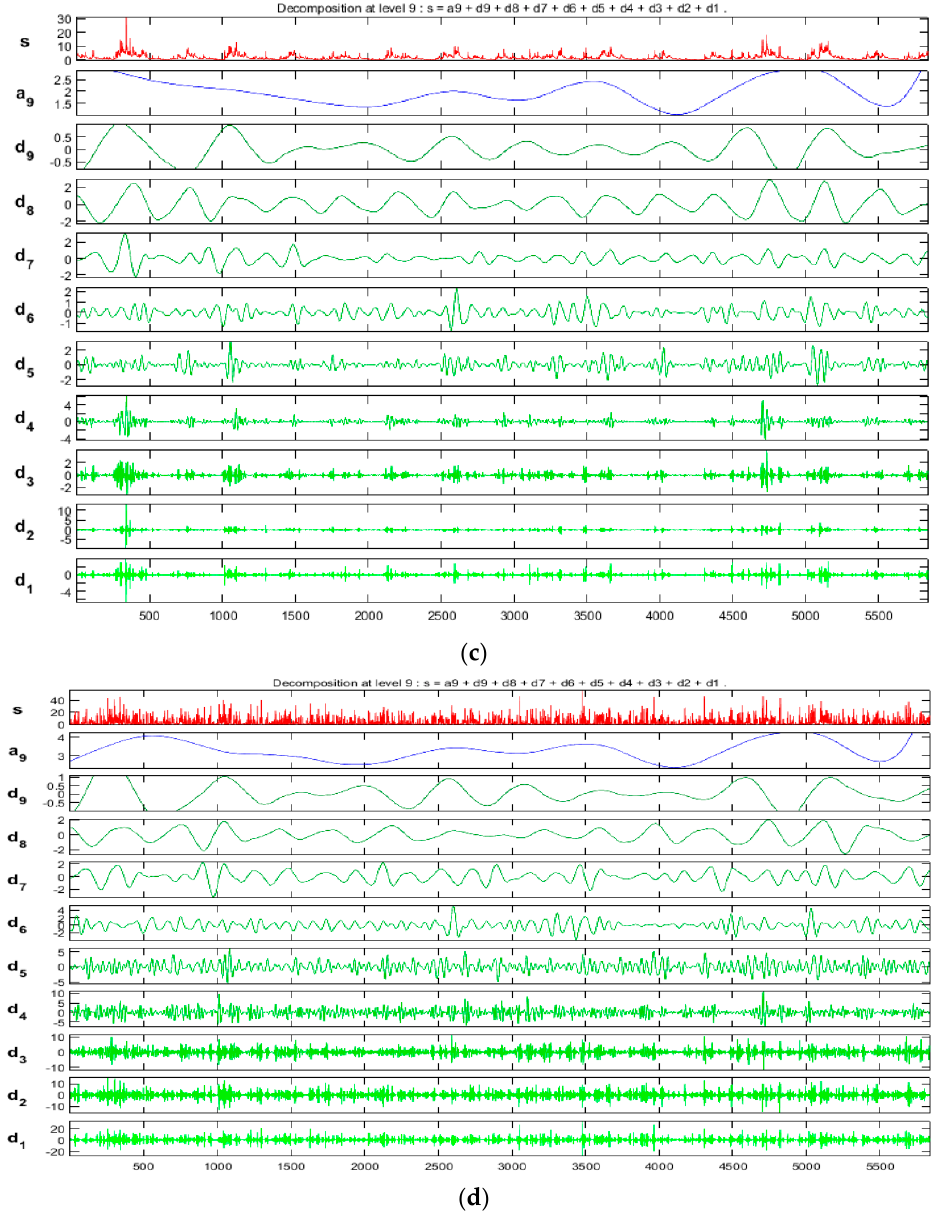
Figure 6. Discrete wavelet transform (DWT) sub-series (D1 to D9) and approximation (A9) for Teifi at Glanteifi ( a ) discharge ( b ) rainfall and Fal at Tregony ( c ) discharge ( d ) rainfall.